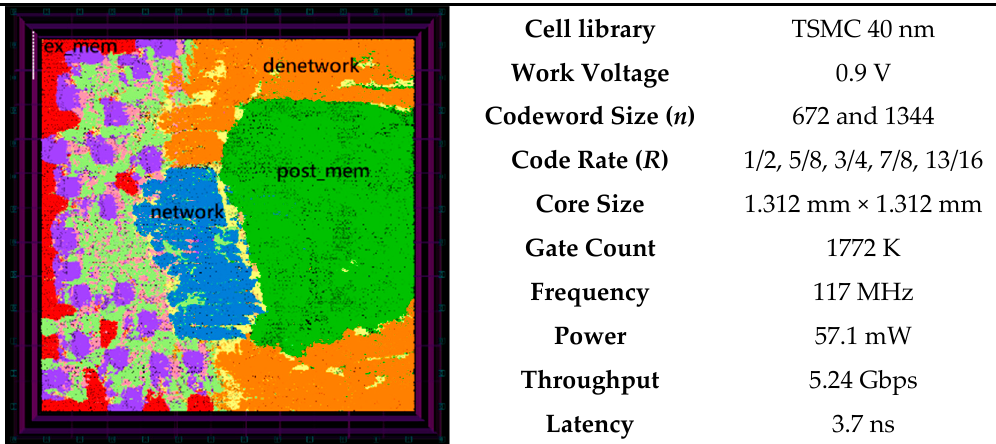
Figure 33. Chip summary and layout of the proposed reconfigurable multi-standard LDPC de- coder.